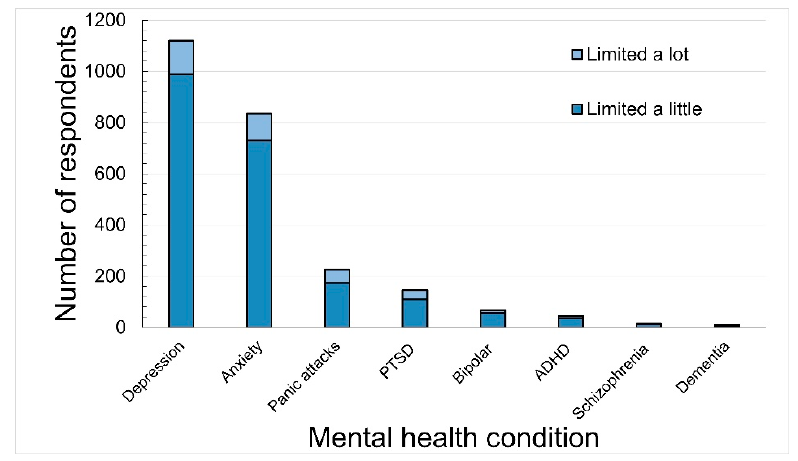
Figure 1. Number of respondents who selected specific mental health conditions ( n = 1496). Note: dementia includes Alzheimer’s disease. Table 2. Matrix showing the number of respondents who reported one or two mental health conditions. Note: dementia includes those reporting Alzheimer’s disease. The coloured cells show the number of people with a single health condition. Limited Little and a Lot